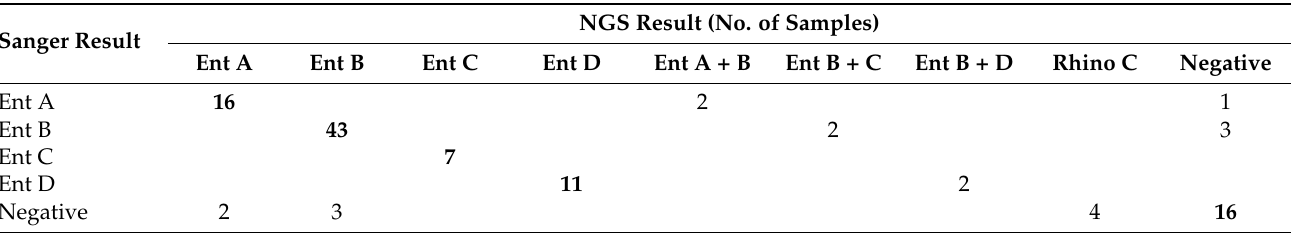
Table 2. Identification of EVs in 112 clinical samples from England using NGS analysis compared with conventional Sanger sequencing by EV species 1 .